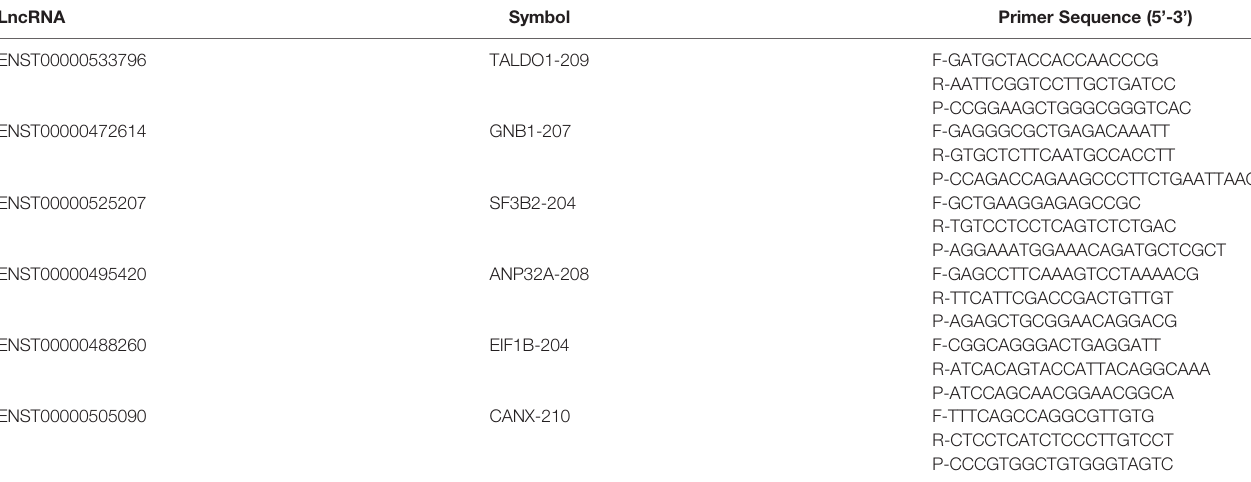
TABLE 2 | Primer list. F- refers to the forward sequence, R- refers to the reverse sequence, and P- refers to the probe sequence. LncRNA